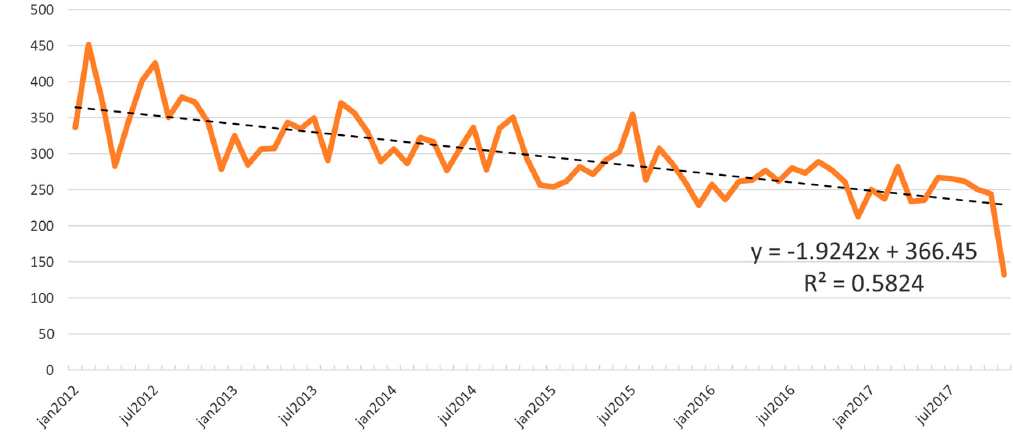
Figure 1. Accident trend in the primary sector in Italy over time (2012–2017).